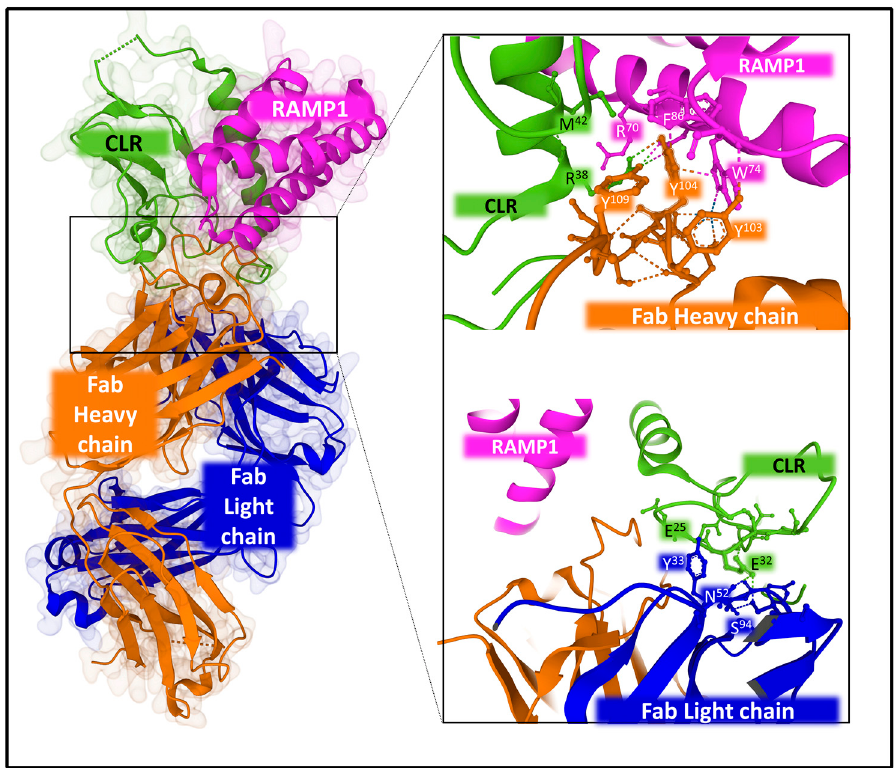
Figure 11. Structure of the complex CLR-RAMP1 co-crystalized with monoclonal antibody 6UMG. The figure on the right-hand side depicts some atomic contacts of the antibody heavy chain (upper panel) and the antibody light chain (lower panel) with the interface of the complex CLR-RAMP. The structures corresponding to PDB ID 6UMG [129] were obtained from the Pro- tein Data Bank (PDB [65]) and designed with Mol* free web-based software [71].